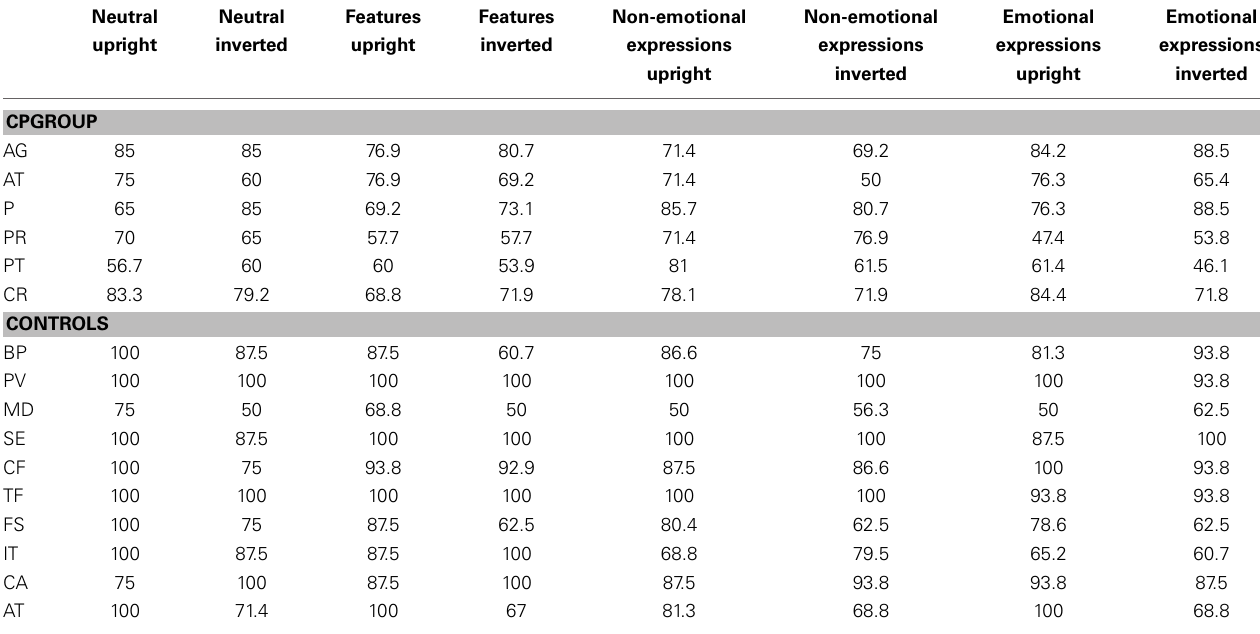
Table 3 | The mean percentages of correct responses for each participant subdivided for each condition in Task 1 (Recognition task).